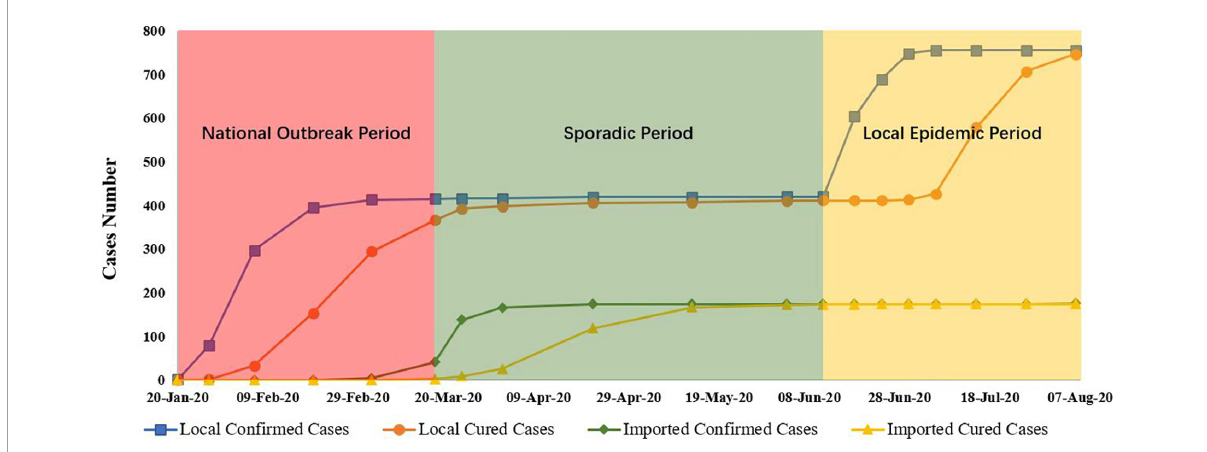
FIGURE2 COVID-19 cases during the national outbreak, sporadic, and local epidemic periods in Beijing. Data were obtained from the Beijing Municipal Health Commission (available at http://wjw.beijing.gov.cn/). COVID-19 , coronavirus disease